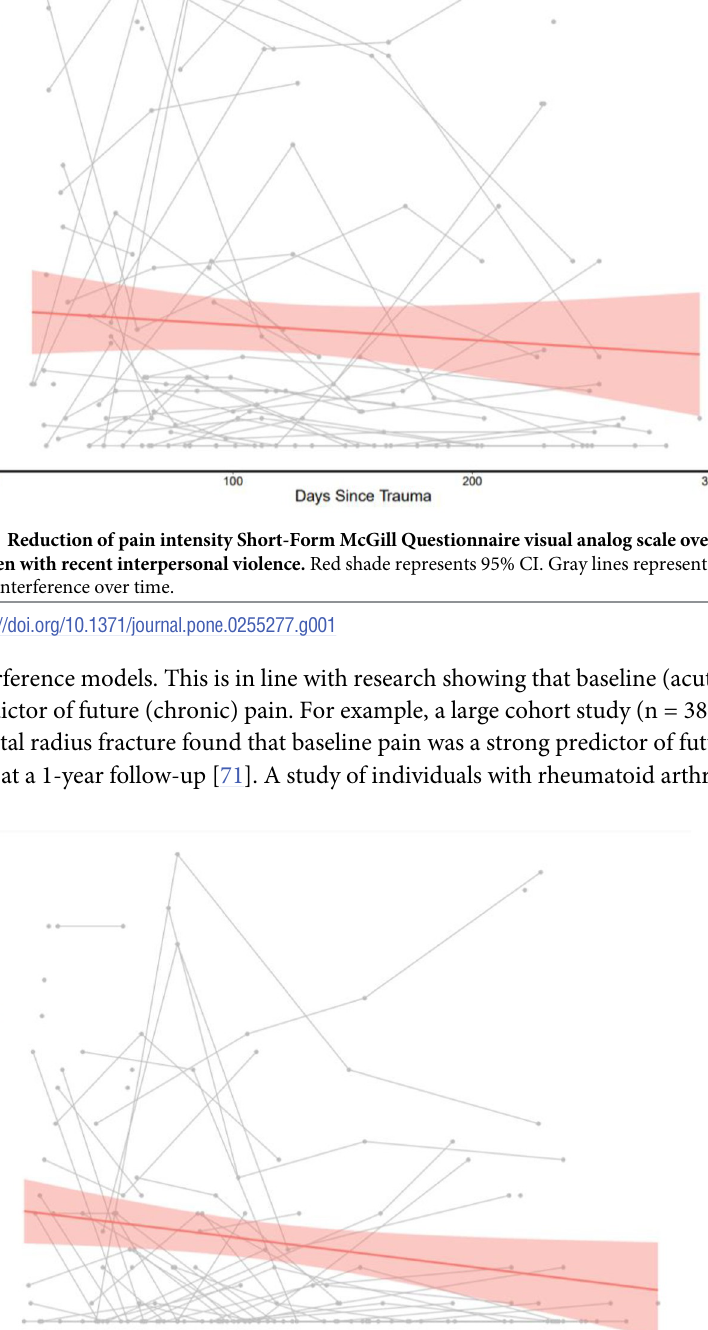
Fig 2. Reduction of pain interference over time in young women with recent interpersonal violence. Red shade represents 95% CI. Gray lines represent individual changes in pain interference over time.